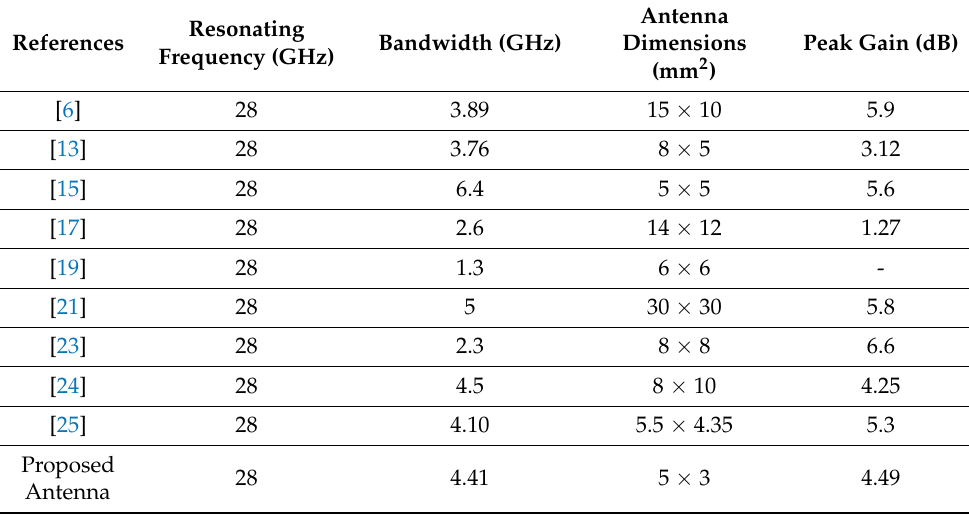
Table 5. Comparative analysis of the proposed antenna and antennas in the existing